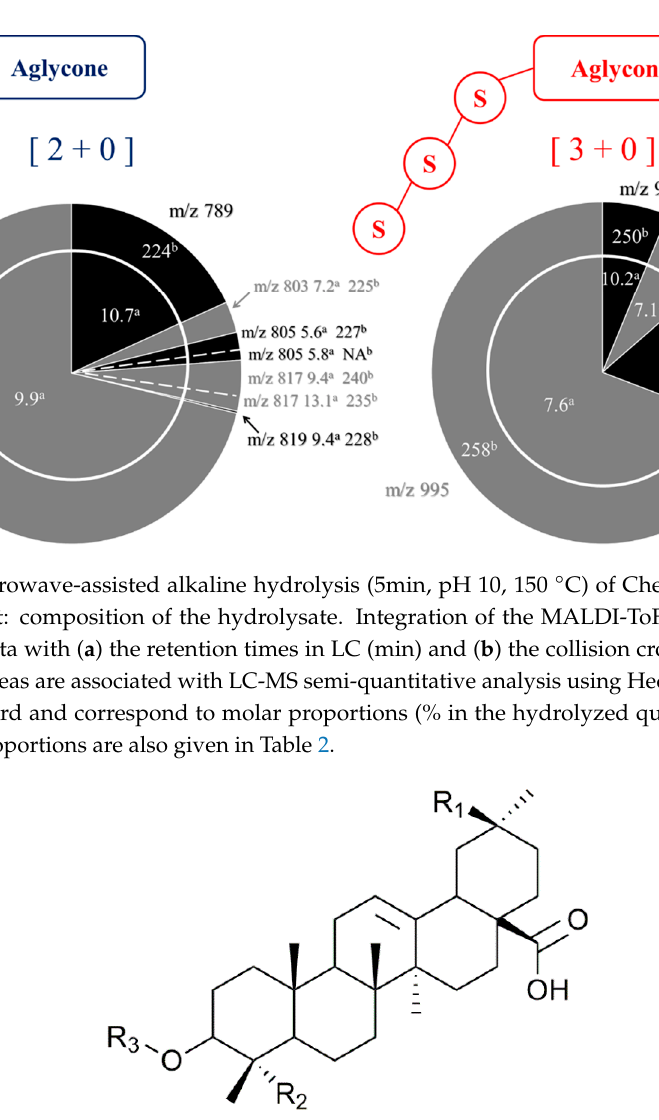
Figure 11. Schematic structure of the hydrolyzed saponins extracted from the quinoa husk. All the functions in R 1 , R 2 and R 3 are described in Table 2.